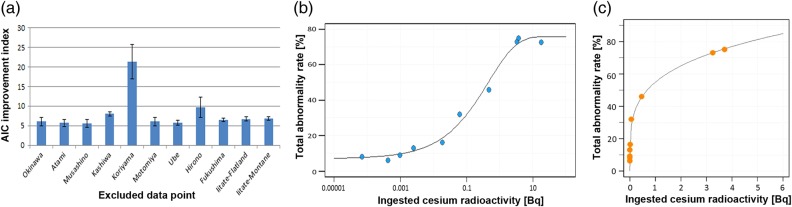
Mathematical analyses of the total abnormality rates (including the deaths of larvae, prepupae, and pupae and the morphological abnormalities of adults), which were obtained from high [34] and low [38] contamination levels, in response to cesium radioactivity ingested by Okinawa larvae. The horizontal axis represents ingested cesium radioactivity per larva [Bq/body]. (a) AIC improvement index. The highest AIC improvement index is obtained when the Koriyama data point is excluded as an outlier. (b) A Weibull model (type 2, 4 parameters) is the best mathematical fit when the Koriyama data point is excluded. The distribution pattern is loosely sigmoidal. The threshold is approximately 10 mBq/body, and the saturation point is approximately 10 Bq/body. (c) A power function model is the best mathematical fit when the Koriyama and Iitate-montane data points are excluded.